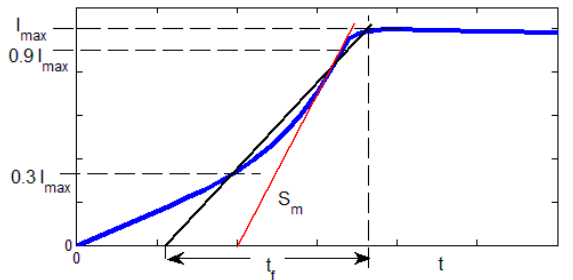
Figure 2. Lightning current waveform.